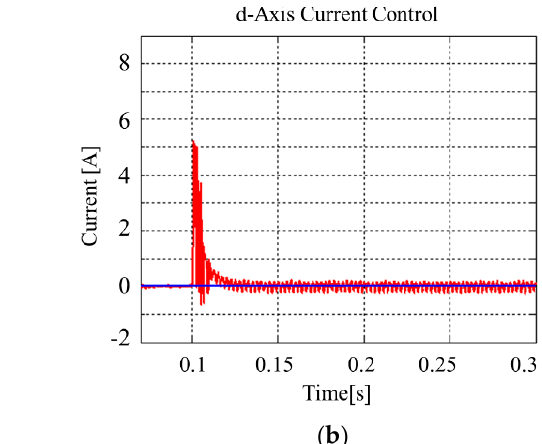
Figure 7. IPMSM and brake model for Matlab/Simulink.